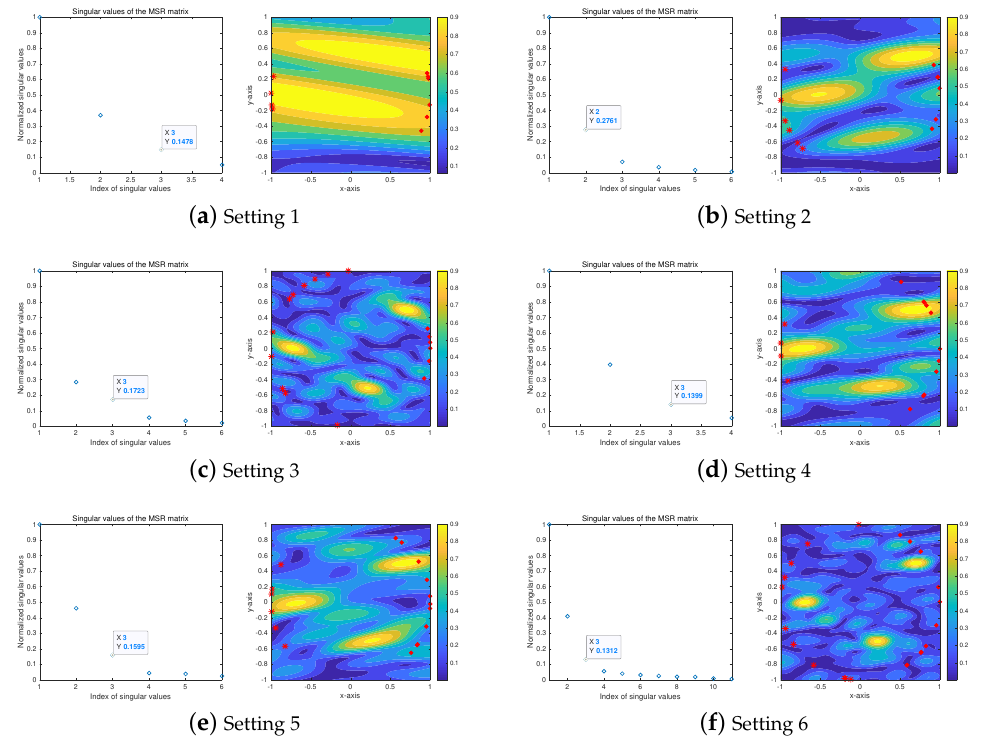
Figure 6. (Example 3) maps of F ε ( r ) . The red-colored marks ◦ and ∗ denote the incident and observation directions,